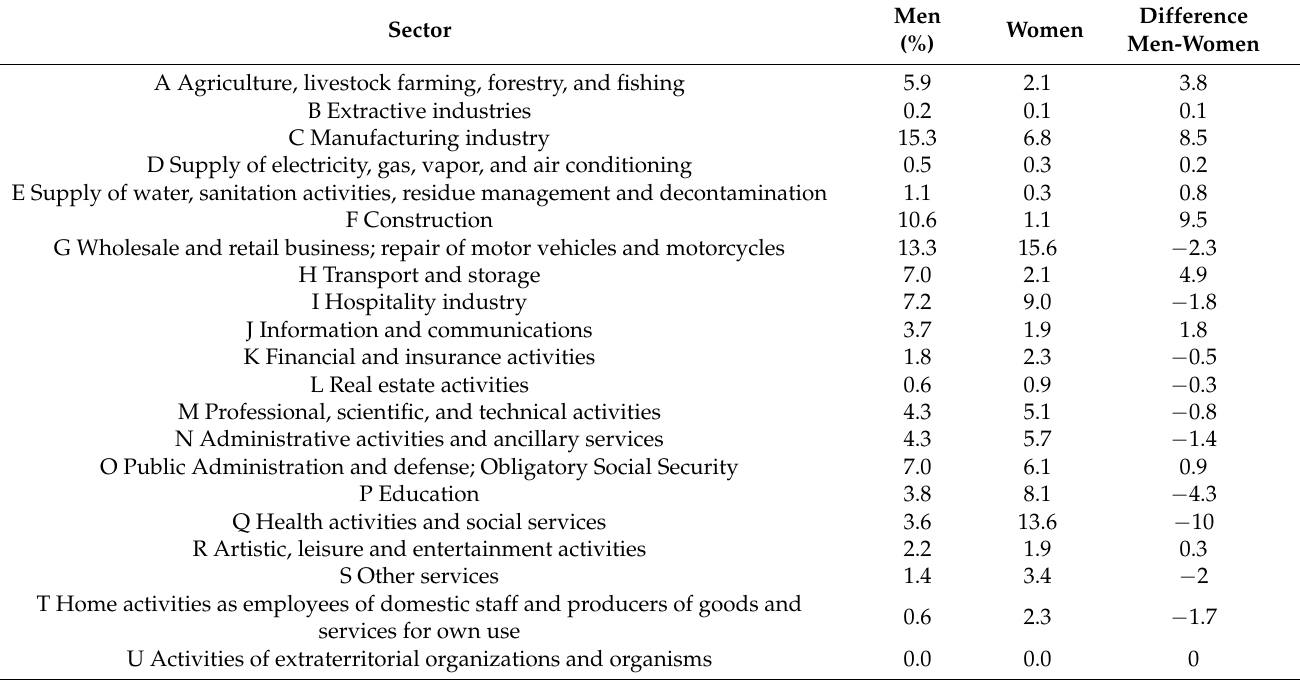
Table 6. Employment by sectors and sex, in percentage (third quarter of 2020). Sector